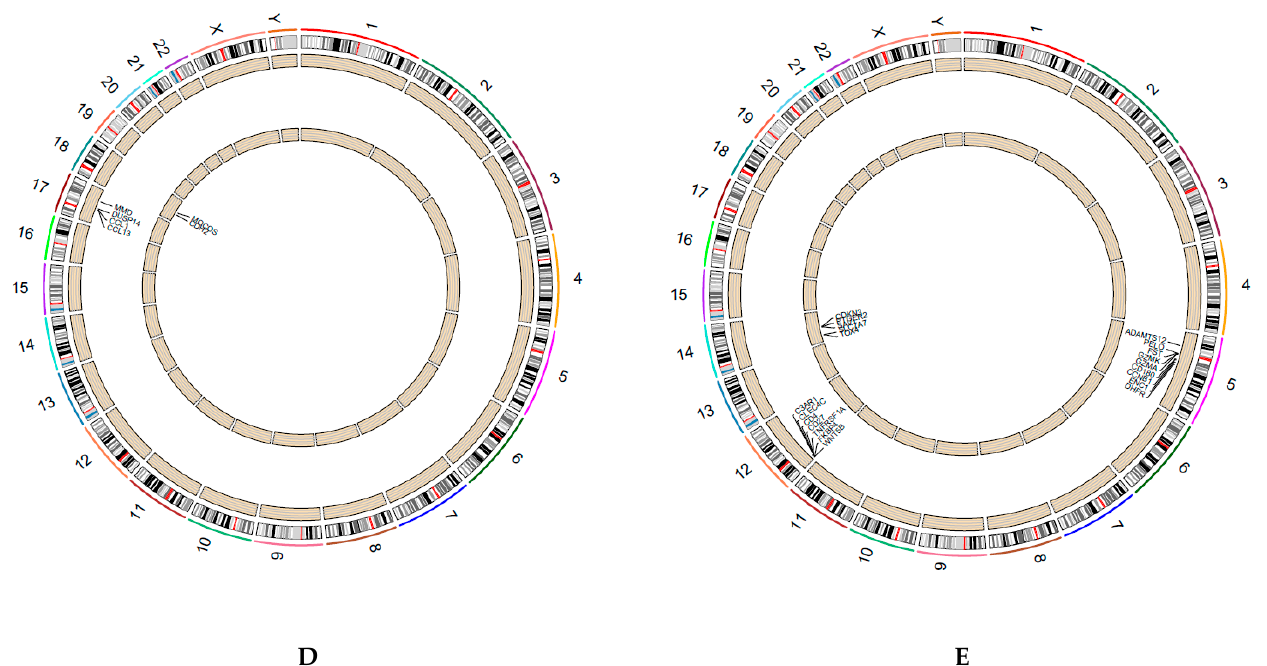
Figure 8. Genomic alteration of classification is different between each subtype. ( A – C ) 30 genes with the most frequent mutation in clusters 1, 2 and 3, respectively. ( D , E ) Copy number variation (CNV) in cluster 1 and cluster 2, respectively.